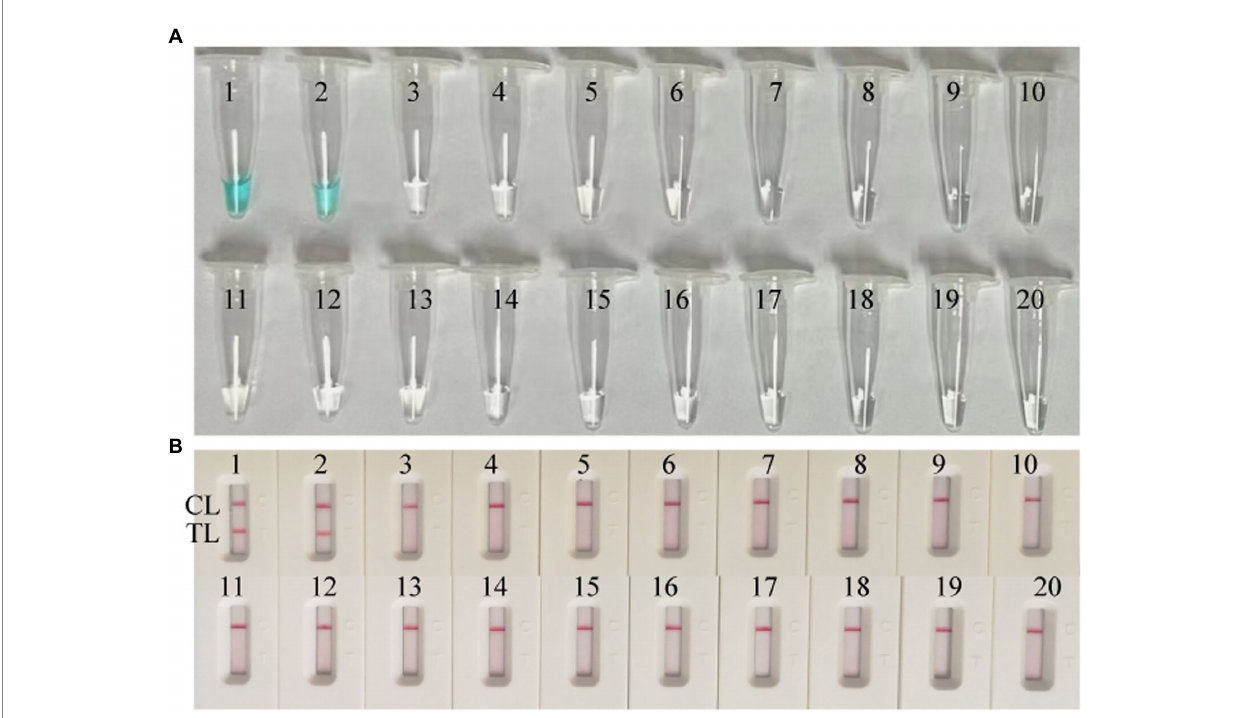
FIGURE 3 Specificity conformation for MPX–LAMP-LFB assay. Specificity of the MPX-LAMP-LFB assay was confirmed by testing the LAMP products with visual detection reagent (A) and LFB (B) methods. Biosensors/Tubes 1–2 showed the LAMP reaction results of ATI-plasmid and the pseudotyped virus; Biosensors/Tubes 3–19 showed the LAMP reaction results of the 17 non-MPXV viral pathogens (Supplementary Table S1); Biosensor/Tube 20 showed the LAMP reaction results of blank control. TL, test line; CL, control line.